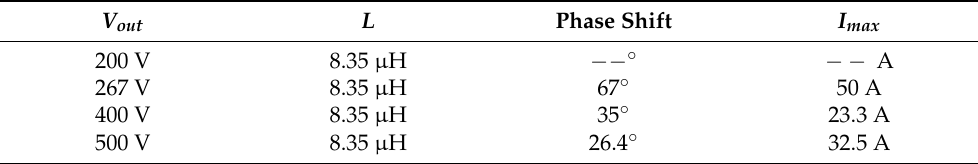
Table 4. φ and I max values for L = 8.35 µ H at P out = 7.5 kW.